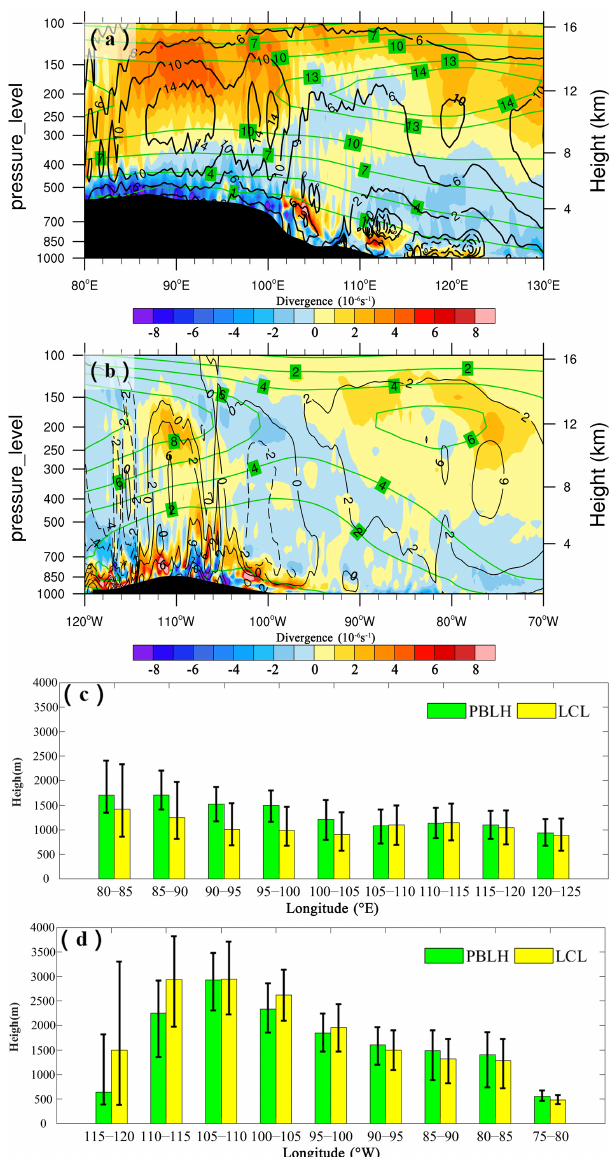
Figure 4. Vertical distribution of summer mean divergence (10 − 6 s − 1 ) (shaded) at 14:00LT from 2010 to 2019 at the latitude across sections from 30 to 35 ◦ N in (a) East Asia and (b) North America. The green and black contours denote the summer mean U (ms − 1 ) and W (10 − 2 ms − 1 ) wind components with the zonal circulations, respectively. The solid and dashed contour lines repre- sent the positive and negative values, respectively. The black-shaded areas represent the topography. Panels (c) and (d) are the PBLH (green) and LCL (yellow) versus longitude in East Asia and North America, respectively. The bar and error bar represent the median values and IQRs,